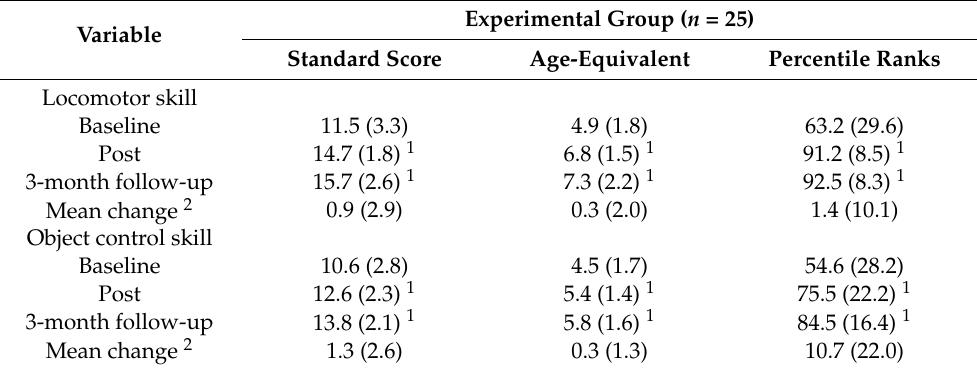
Table 3. Test of Gross Motor Development (TGMD-2) locomotor and object control scores in experi- mental group of children who took part in all three sessions ( n =